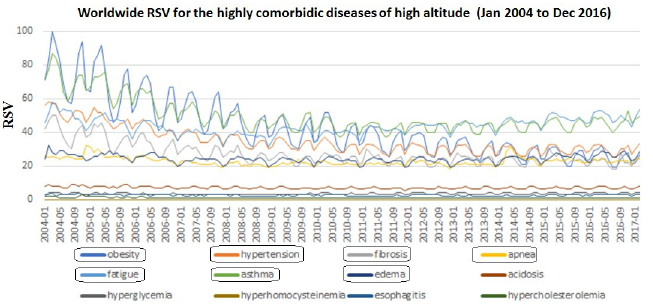
Fig 7. The monthly widespread google trend relative search volume (RSV) collected for the “highly comorbid diseases of high altitude (core DSN)” with obesity (dark blue colour) as the benchmark disease. The average RSV of the core-DSN was diseases more than 20 for the entire period were boxed. These seven diseases were named as “severe seasonal comorbid lifestyle diseases (SCLD)”.